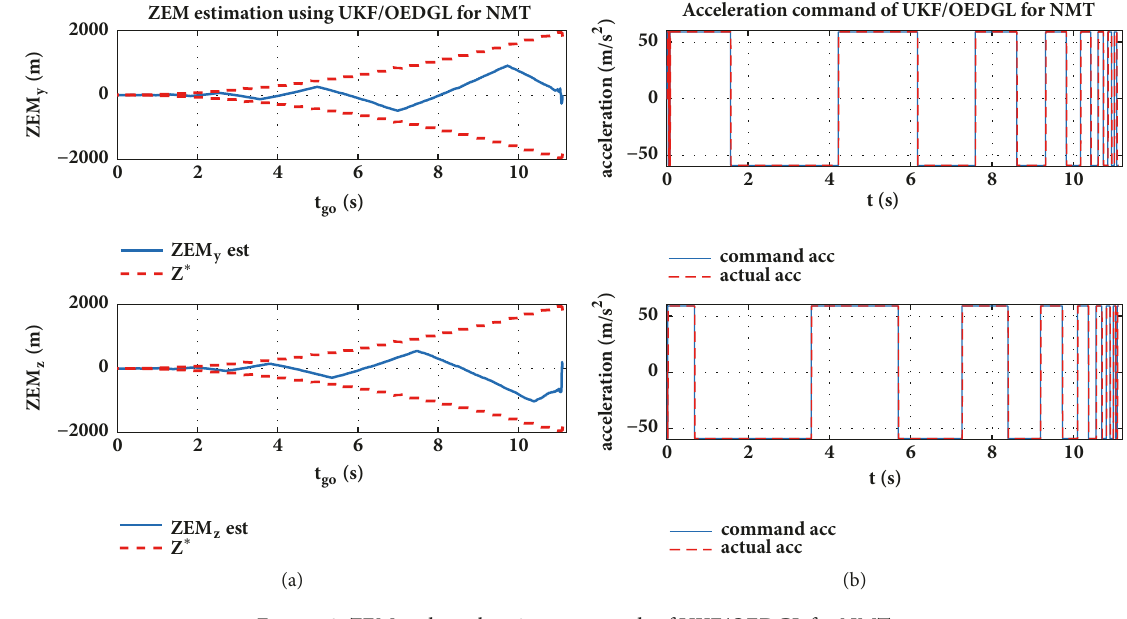
Figure 8: ZEM and acceleration commands of UKF/OEDGL for NMT.